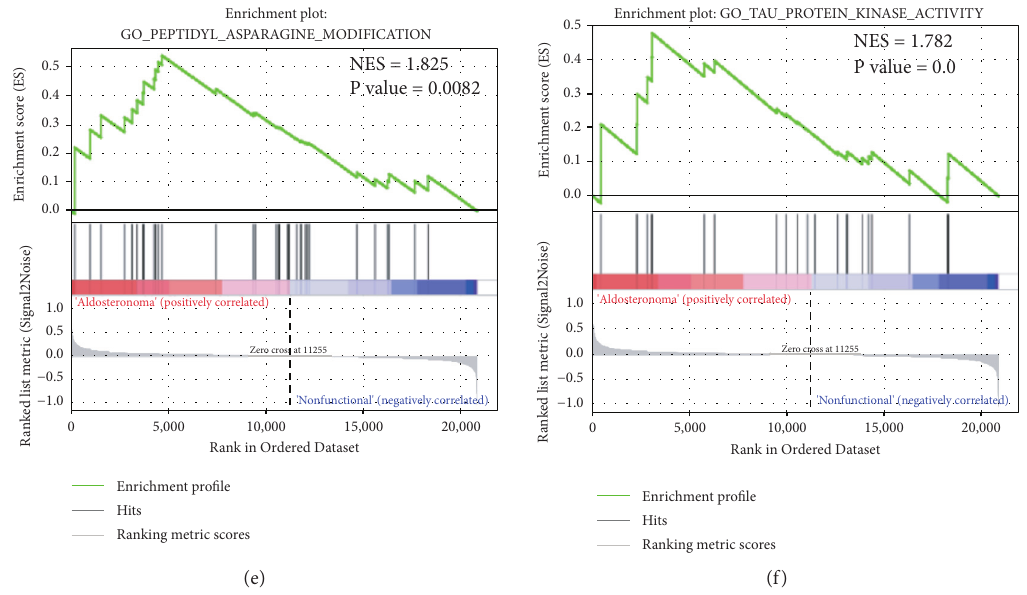
Figure 6: GSEA analysis for GO enrichment using combined datasets. IRE1, an endoplasmic reticulum stress